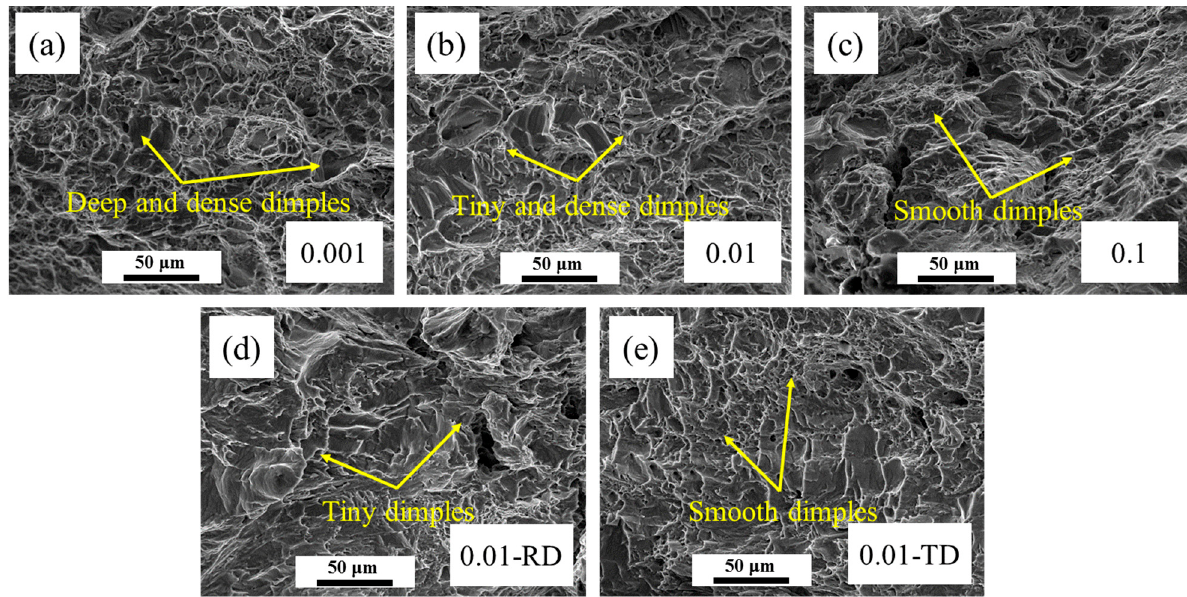
Figure 13. Fractographs of tensile failed specimens under various displacement rates: ( a ) biaxial, 0.001 mm/s, ( b ) biaxial, 0.01 mm/s, ( c ) biaxial, 0.1 mm/s, ( d ) uniaxial-RD, 0.01 mm/s, ( e ) uniaxial-TD, 0.01 mm/s.